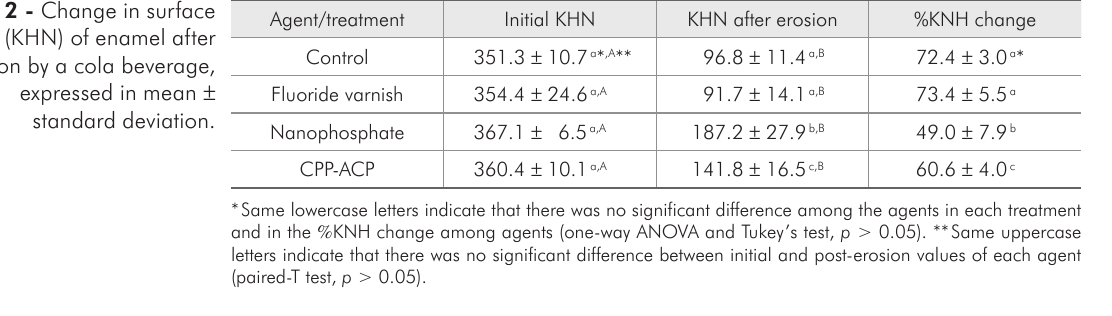
Table 2 - Change in surface hardness (KHN) of enamel after erosion by a cola beverage, expressed in mean ± standard